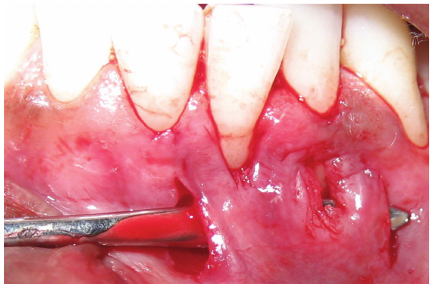
Figure 1: Intraoral photograph showing Miller’s class I recession in the mandibular left central incisor and the fenestration defect (arrow).